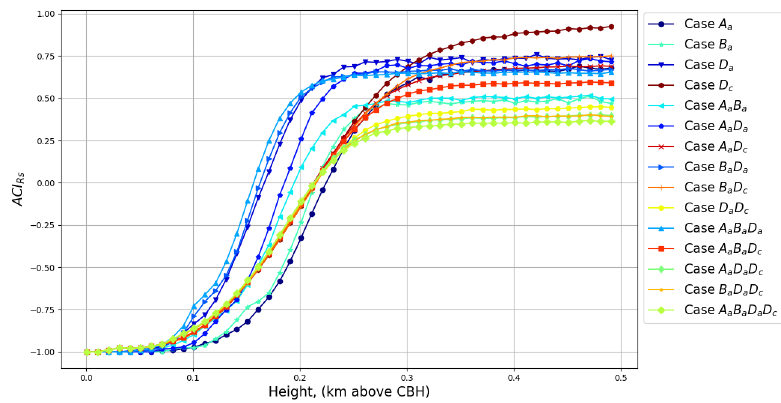
Figure A8. ACI Rs for different cases according to the legend.